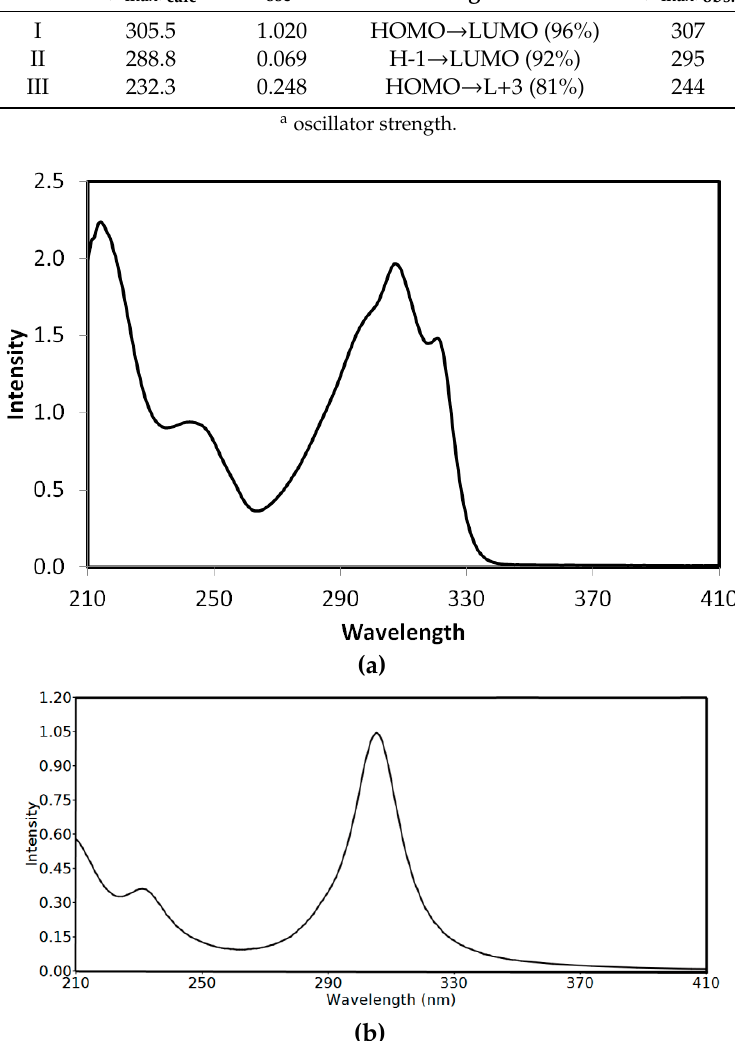
Figure 10. Presentation of the molecular orbitals included in the electronic transitions of 2 in ethanol as solvent. The definition of I , II and III refer to Table 5. In addition, the geometry optimization is performed in DMSO as solvent, then the NMR chemical shifts are calculated in the same solvent using TMS as internal standard. The results are summarized in Table S4 (Supplementary Data), in comparison with the experimental data. Moreover, graphical plots of the experimental chemical shifts against the calculated data for protons and carbons are presented in Figure 11. As can be seen from this figure, the straight lines have good correlation coefficients, indicating the good agreement between the calculated and experimental results.